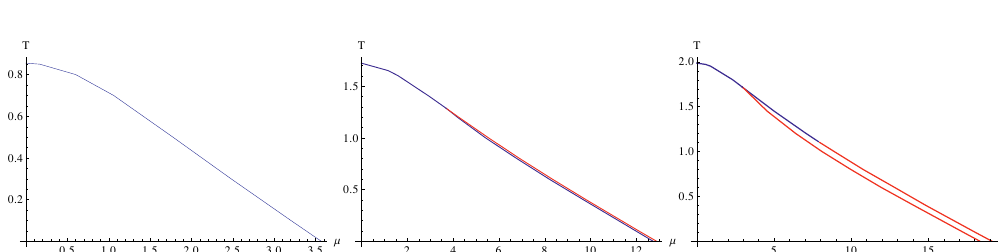
Figure 4. Plots of three possible phase diagrams for the choices A = 3 , 15 , 30 [4]. Large (small) A gives second (first) order transition at low T . Γ = 1 ,λ = 1 .